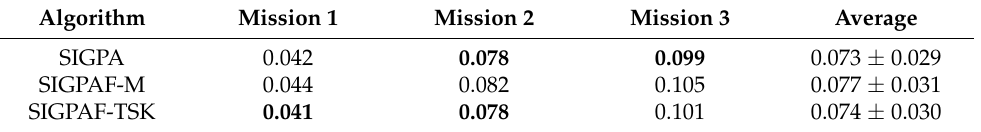
Table 2. Mean Computing time in milliseconds (ms) of SIGPA, SIGPAF-M, and SIGPAF-TSK algorithms.